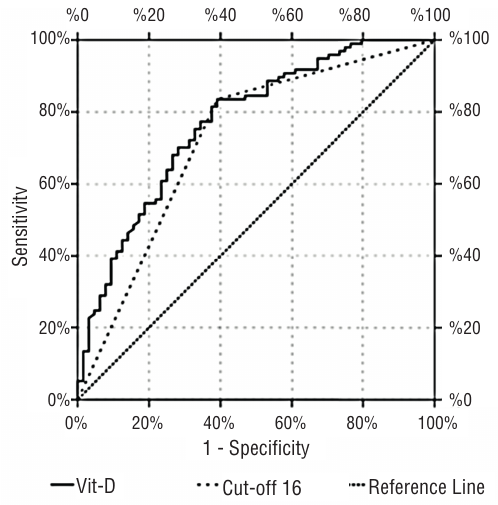
Figure 1 - Receiver operating characteristic (ROC) curves of vitamin D for the prediction of premature